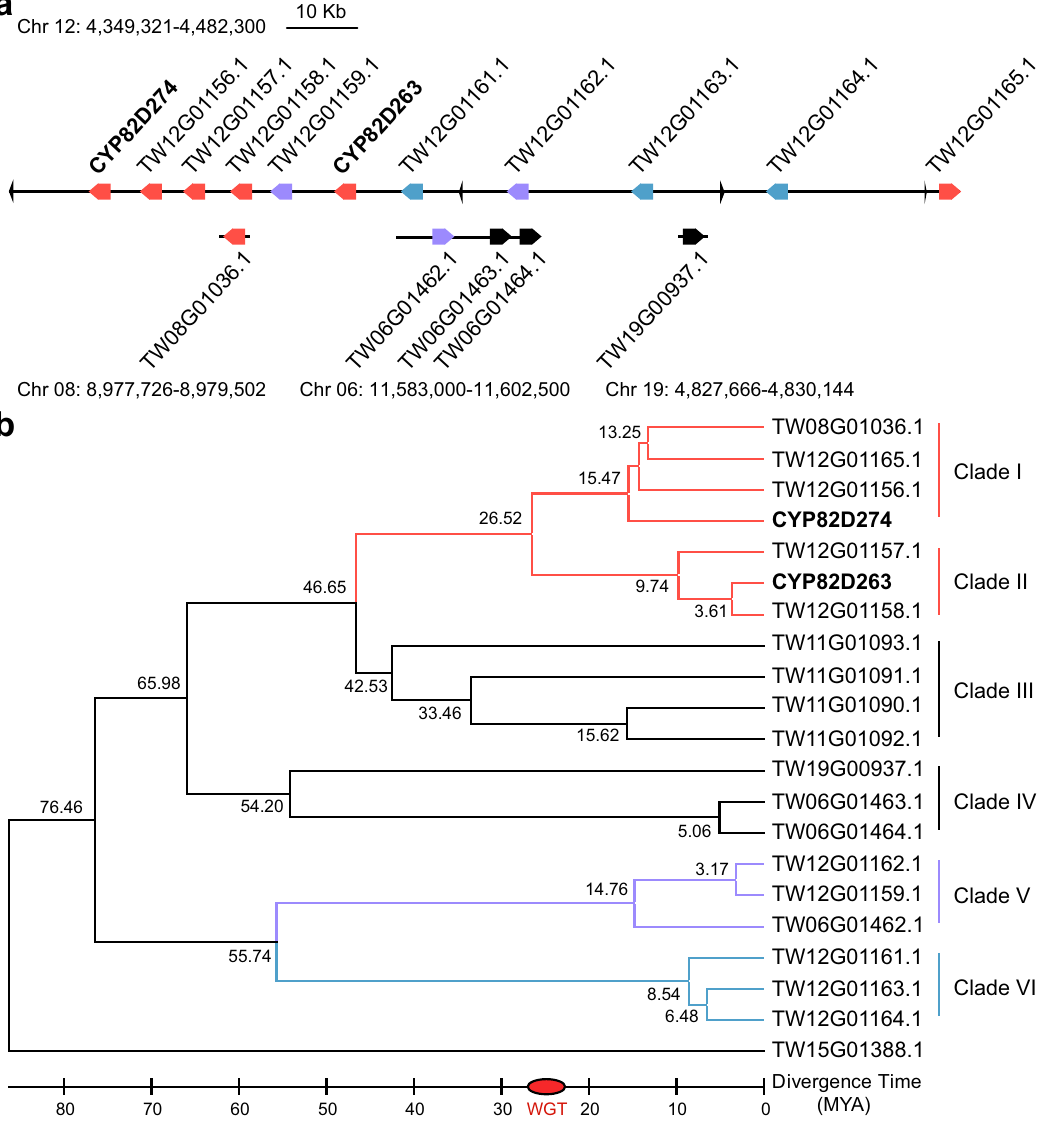
b Phylogenetic analysis of the TwCYP82D genes. The phylogenetic tree was con- structed based on the maximum likelihood method (1000 bootstraps). The num- bers represent the predicted divergence time and WGT indicates the whole- genome triplication event of T. wilfordii